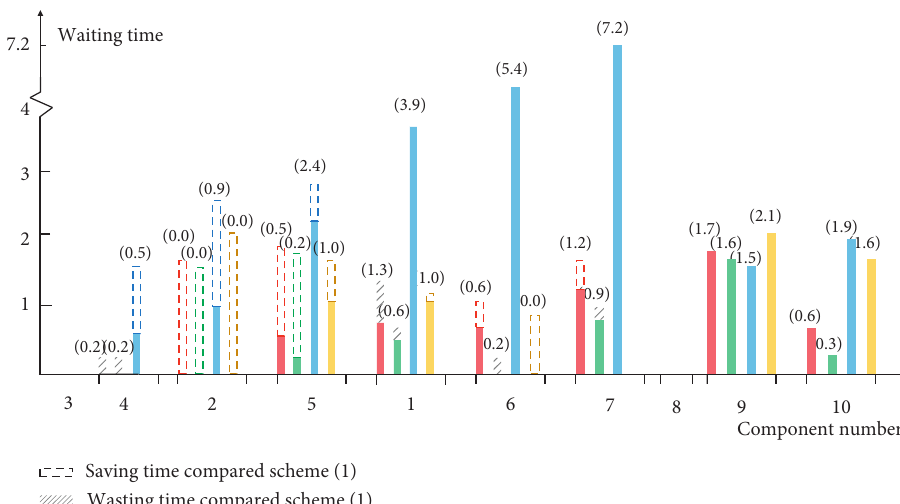
Figure 8: Waiting time chart for scheme